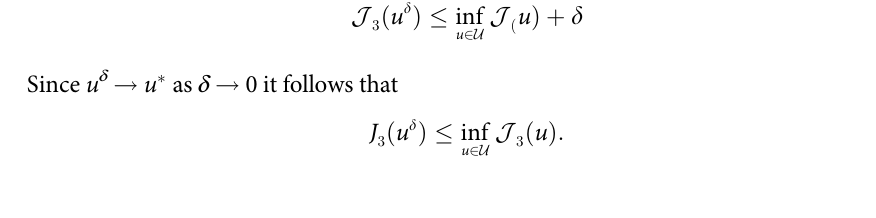
S1 File. Appendix F. Complementary numerical results. Fig A: Optimal Control Functions. Fig B: A simulation of problem P2